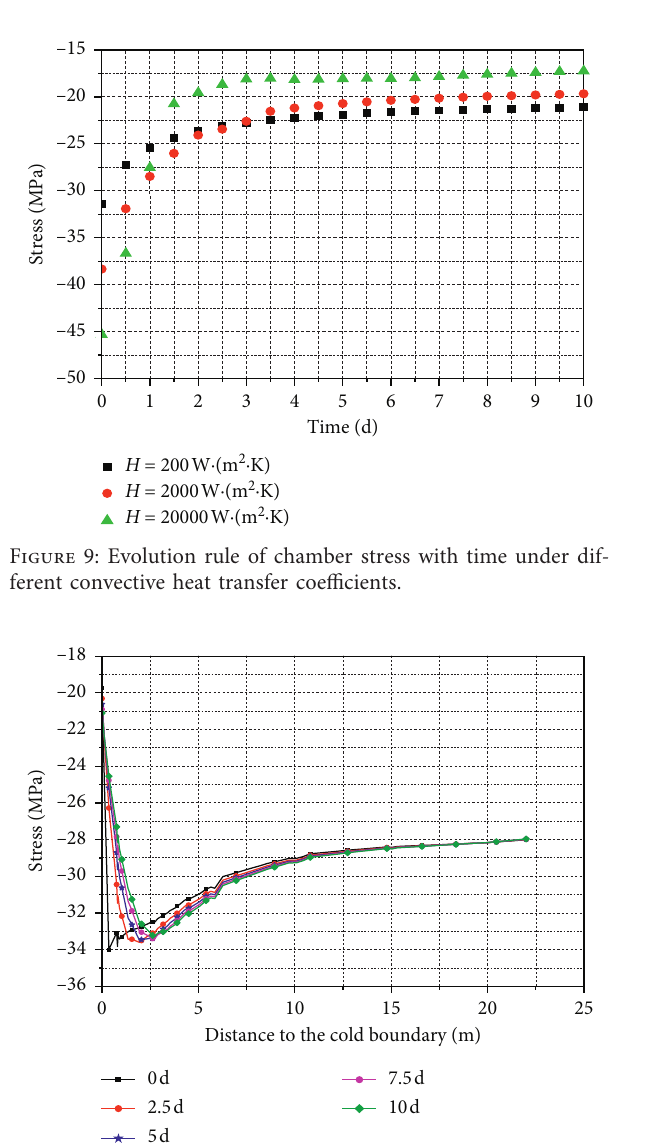
Figure 10: Spatial evolution of stress in the chamber ( H � 200 W/(m 2 ·